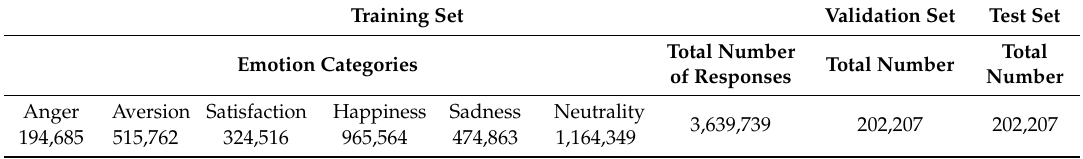
Table 3. Session dataset (STC)